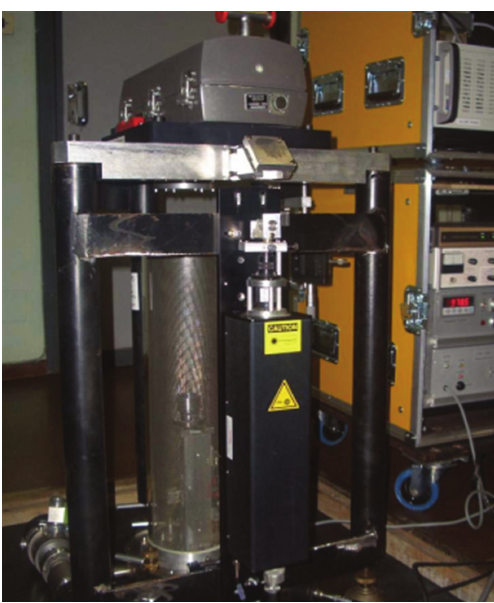
Figure 7: IMGC-02 absolute gravity meter.